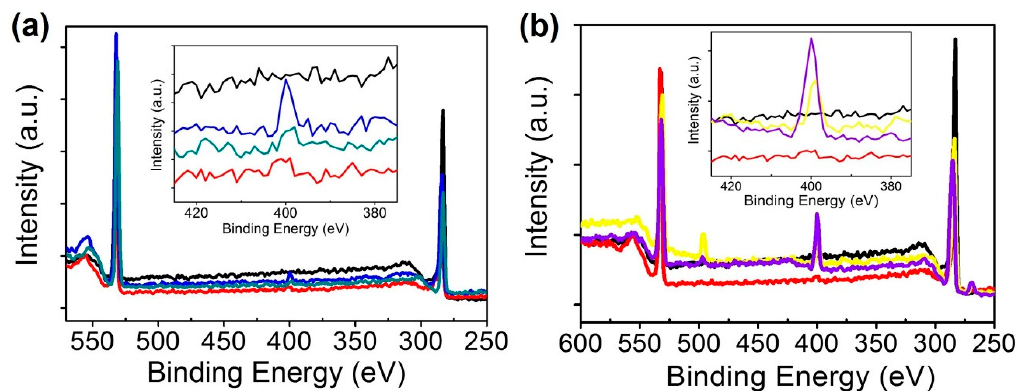
Figure 7. Results of XPS measurements of carbon nanotube surfaces undergoing a series of chemical treatments. Chemical changes on the surface of carbon nanotubes were confirmed based on the presence and content of carbon, oxygen, and nitrogen. ( a ) Identification of specific interaction between BoNT and peptides. ( b ) Confirmation of specific recognition between Anti-BoNT and BoNT. Each color has the following meanings. Black: bare CNTs, red: succinimidy ester (SE)/CNTs, blue: unique peptides/SE/CNTs, greed: Cleaved peptides/SE/CNTs, yellow: Anti-BoNT/SE/CNTs, violet: BoNT/Anti-BoNT/SE/CNTs.